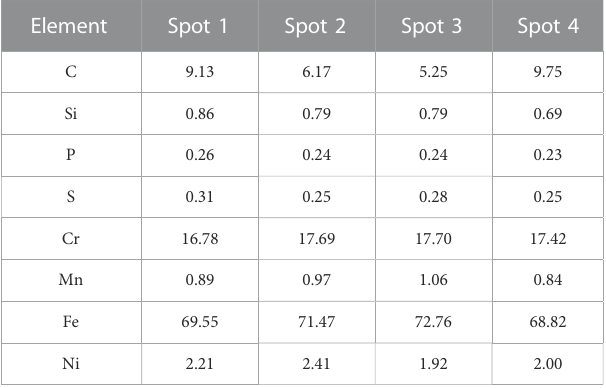
TABLE 3 Surface element distribution of the blade.